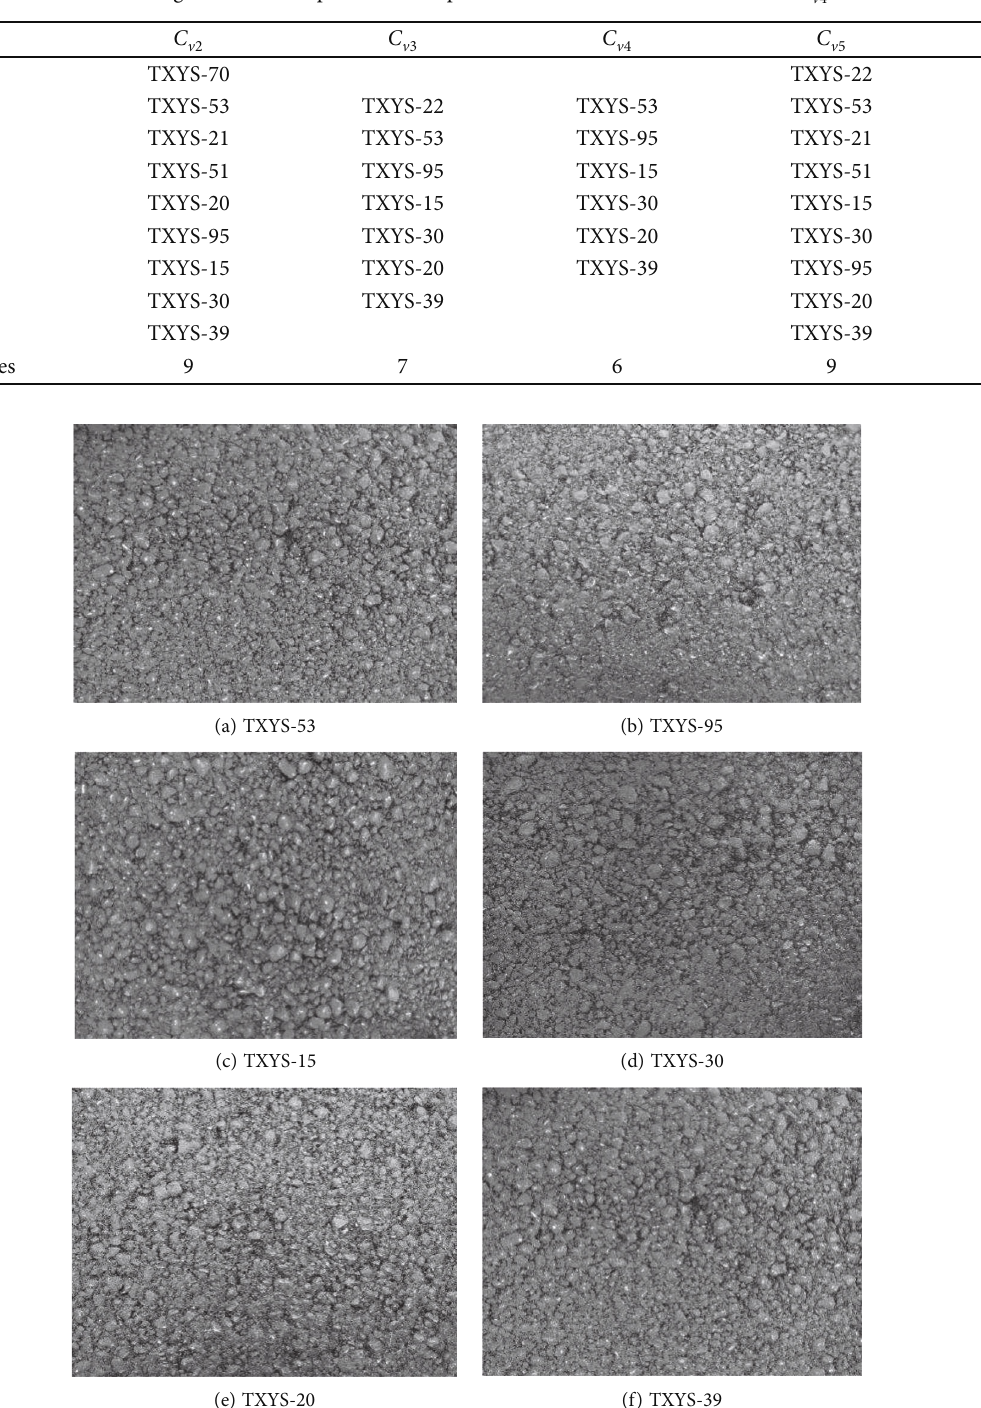
Figure 11: Acquisition images of aggregate segregation in asphalt